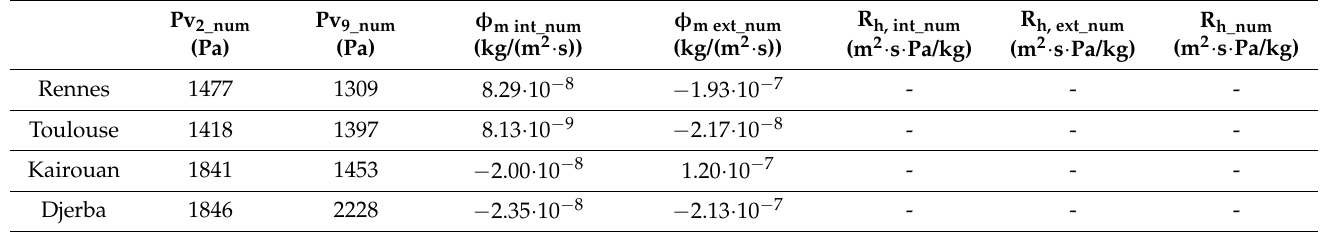
Table 7. Numerical moisture fluxes and R h values at the end of the stabilization